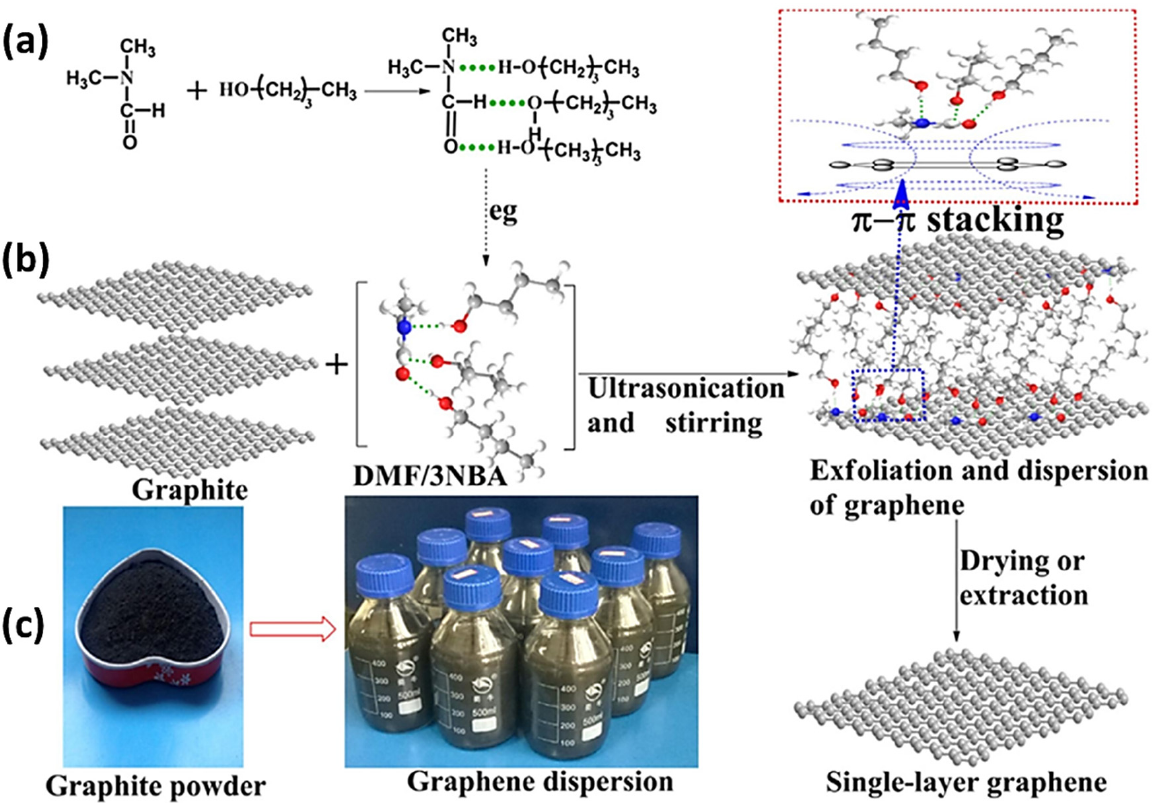
Figure 11. ( a ) Hydrogen bond formation between dimethylformamide (DMF) and n-butanol (NBA) molecules; ( b ) schematic of the graphite exfoliation into few-layer graphene/single-layer graphene; ( c ) powder of graphite and dispersion of graphene-DMF/3NBA. Adopted with permission from [87].